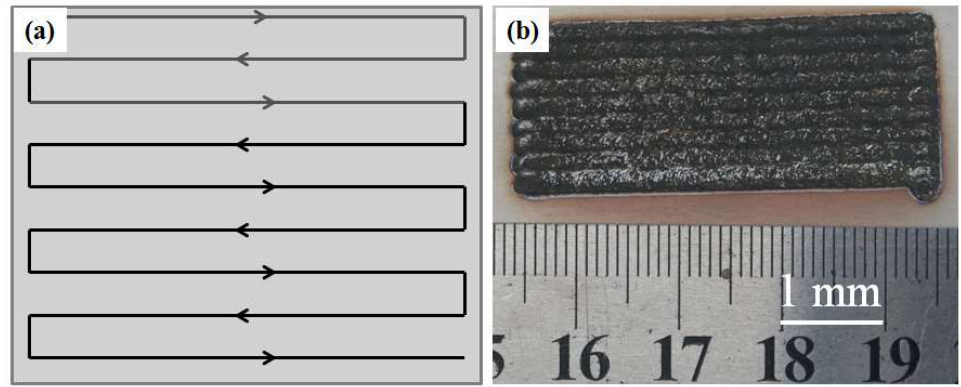
Figure 2. ( a ) The scanning path diagram, and ( b ) the morphology of AlCoCrFeNi HEA coating.